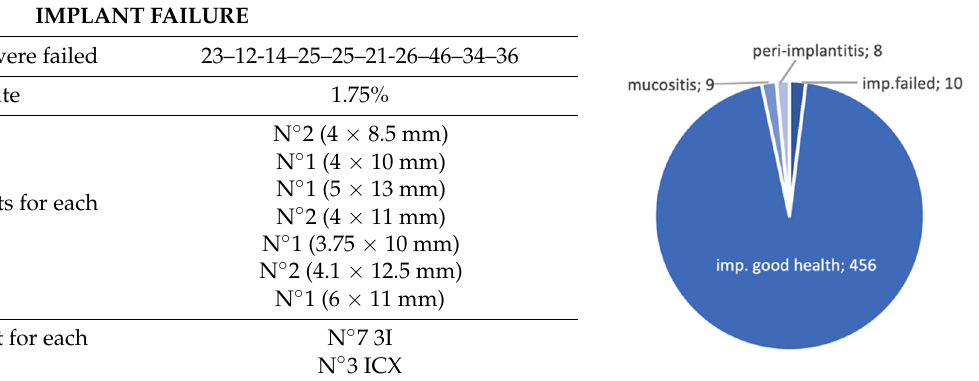
Table 2. Implant failure: partition with site, failure rate, implant dimensions and type of implants lost. IMPLANT FAILURE